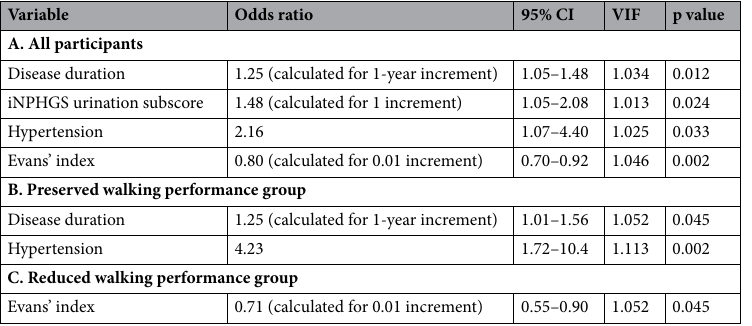
Table 4. Results of multivariate logistic regression analyses. CI confidence interval, iNPHGS idiopathic Normal-Pressure Hydrocephalus Grading Scale, VIF variance inflation